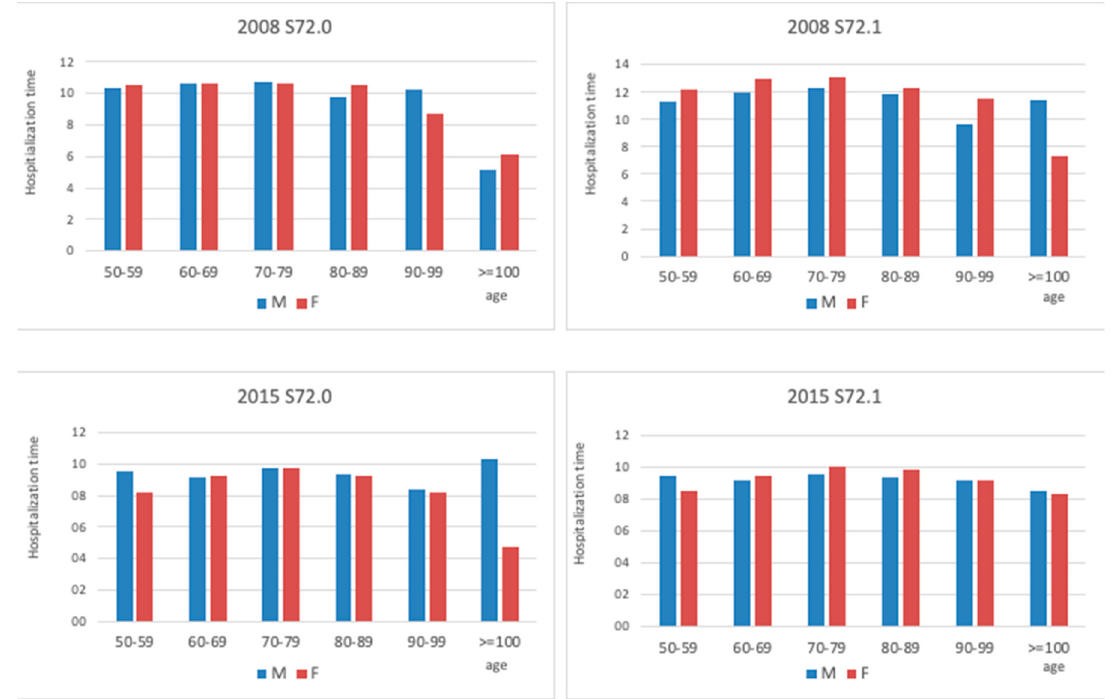
Figure 8. Comparison between hospitalization time due to the femoral neck (S72.0) and pertrochanteric fracture (S72.1) in different age groups at the beginning and end of the study period.